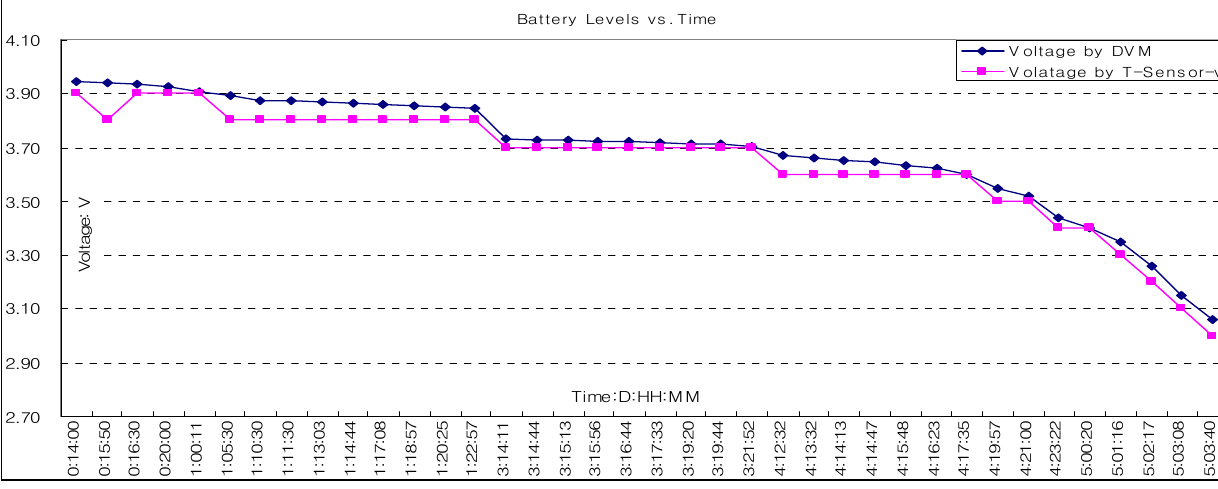
2.702.903.103.303.50